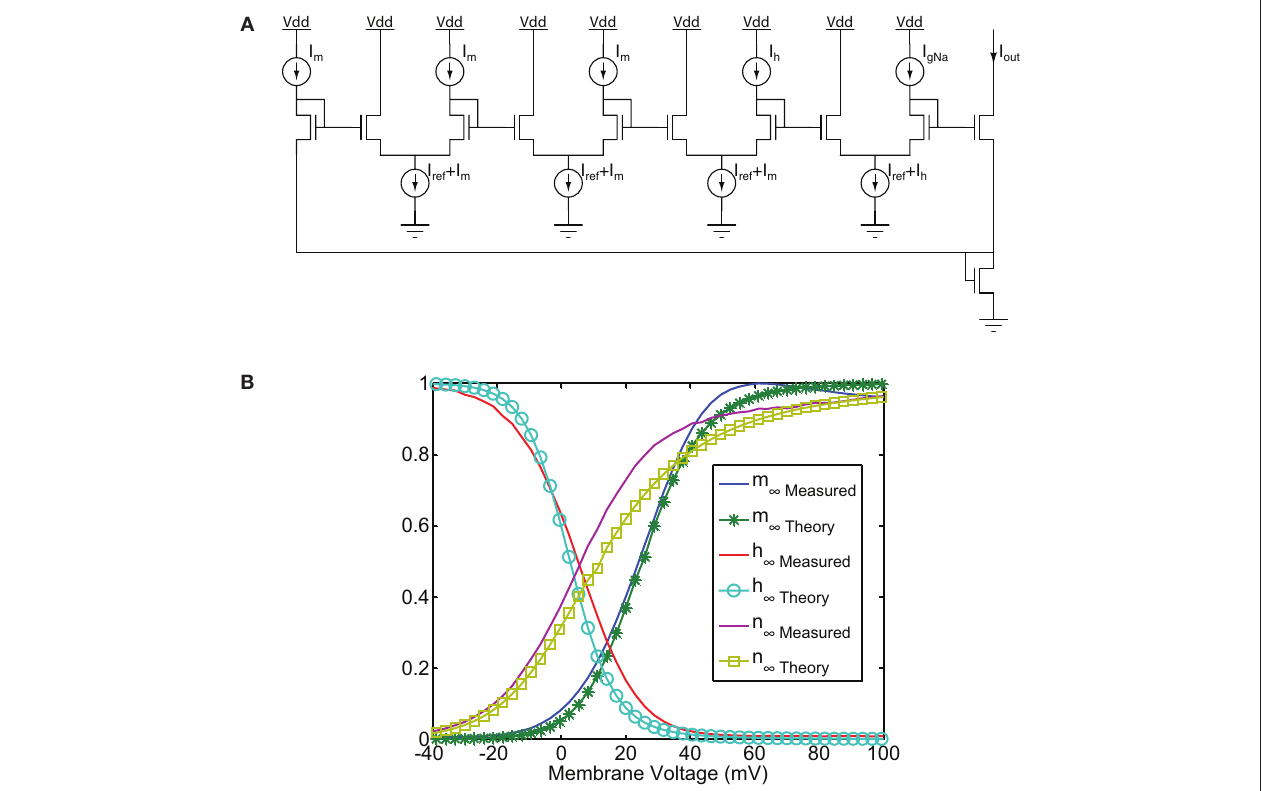
FIgure 9 | (a) Translinear circuit implementing gated conductances of the form x 3 yg used to implement H–H conductance equations (Hodgkin and Huxley, 1952). (b) Steady-state (in)activation functions measured on the sub-threshold H–H neuron (figure adapted from Yu and Cauwenberghs,